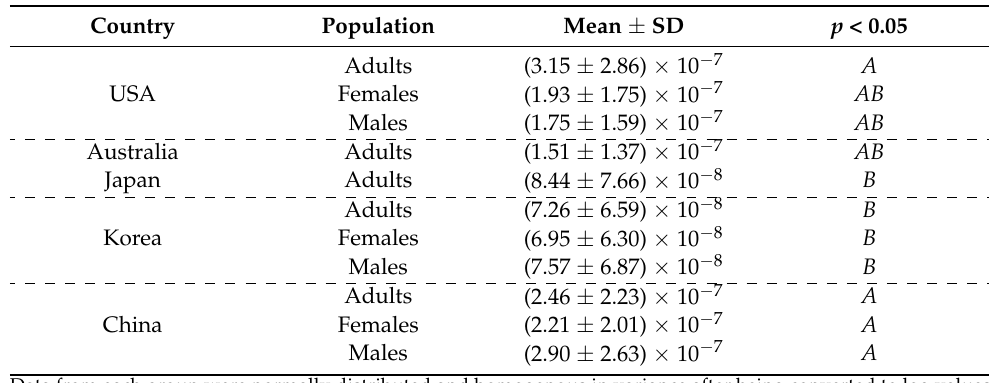
Table 5. The analysis of variance and multiple comparisons among the total cancer risks calculated using Model I based on the different countries ( n = 39).